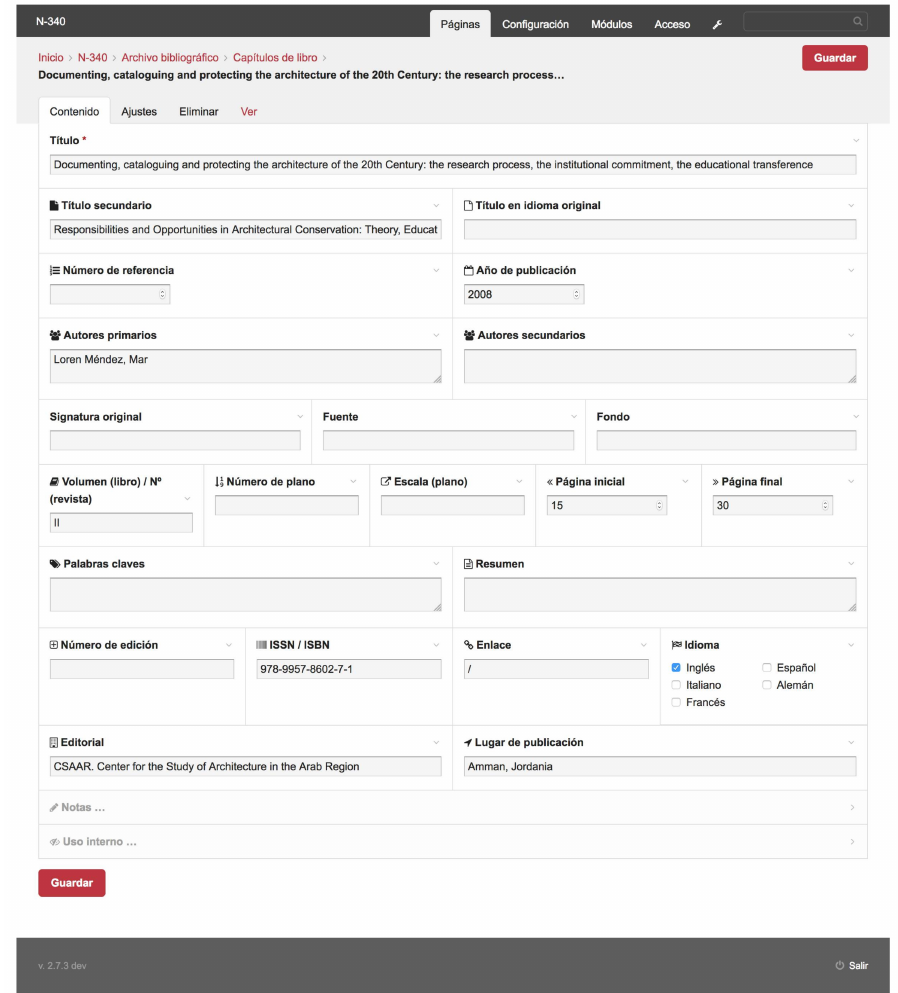
Figure 4. Bibliography database. Customized interface for researchers. Back-end view of the